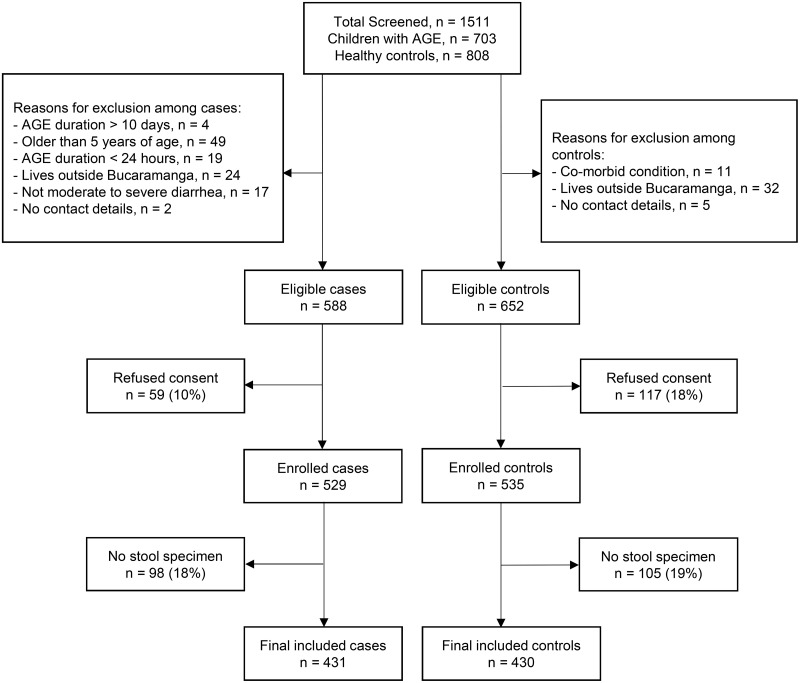
Recruitment of cases of moderate to severe AGE and healthy controls in the metropolitan area of Bucaramanga, Colombia.Cases were children with AGE and controls were healthy children. Abbreviation: AGE, acute gastroenteritis.